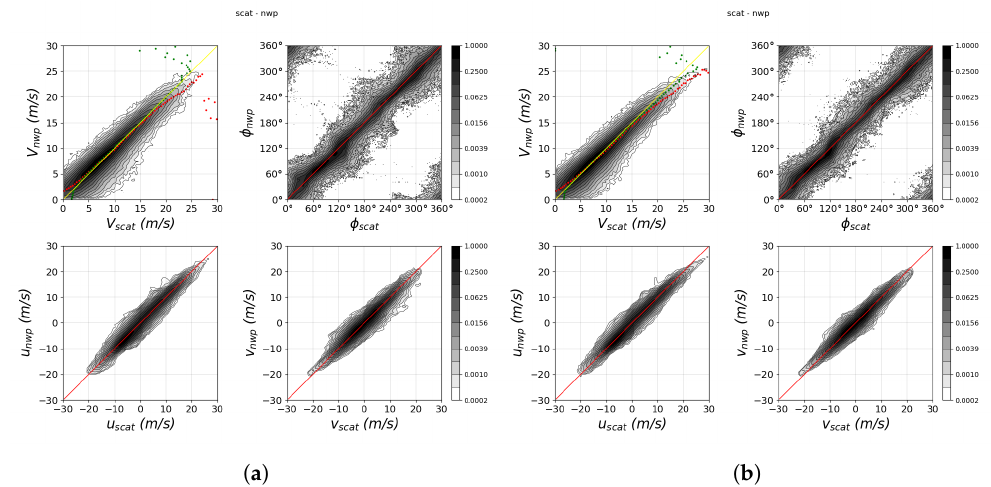
Figure 18. C-band ascending orbits: contoured wind speed, wind direction (wind speed > 4 m/s), u/v components histograms of retrieved winds vs. ECMWF winds, data from 1–9 March 2022: ( a ) noNOC, ( b ) NOCant+. In the wind speed contour, the red dotted line is the average ECMWF wind speed, the green dotted line is the average WindRAD wind, and the yellow straight line is the diagonal.